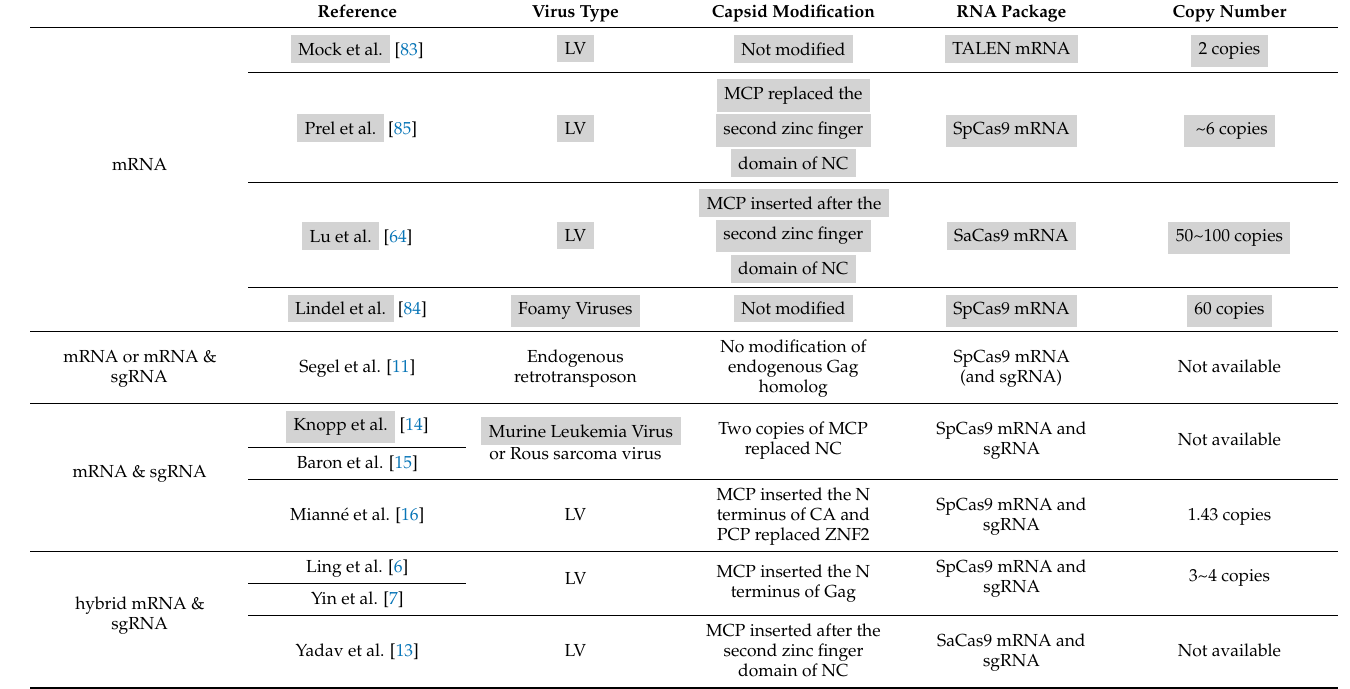
Table 3. Virus-like particle (VLP) mediated RNA